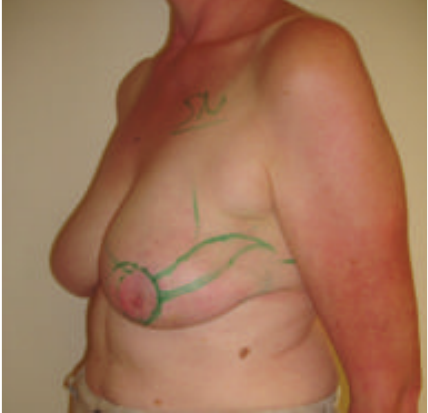
Figure 8: Same patient, oblique view.